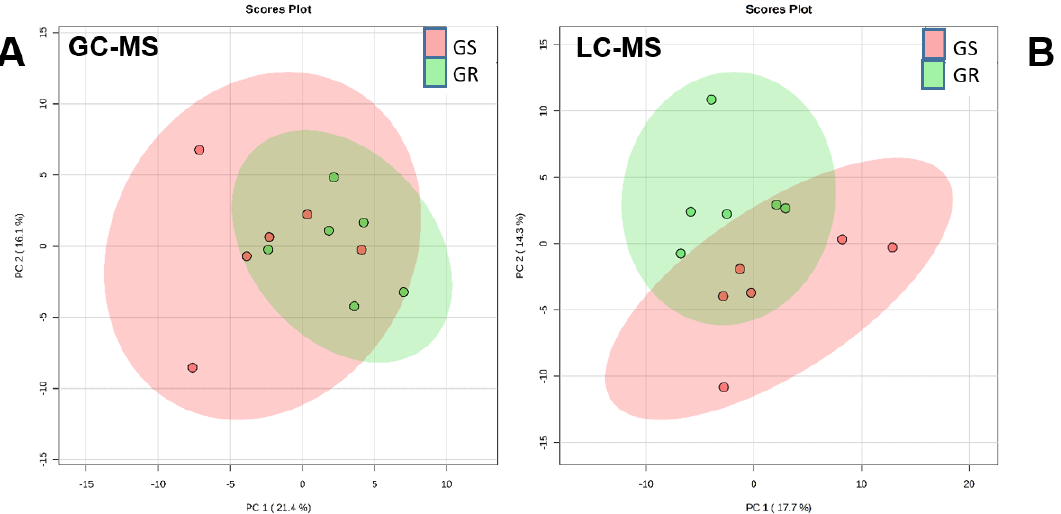
Figure 1. Principal component analysis (PCA) of metabolites detected by GC-MS ( A ) and LC-MS ( B ) in nontreated (control) glyphosate-sensitive (GS, in pink) and glyphosate-resistant (GR, in green) Amaranthus palmeri plants.